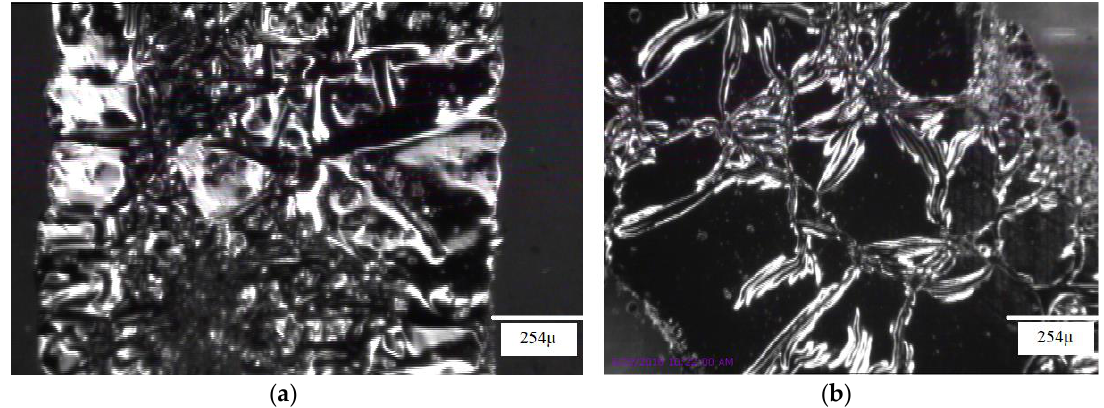
Figure 11. Microscopic images of radially pre-stretched samples at 27% strain with ( a ) straight line, and ( b ) horseshoe patterns.